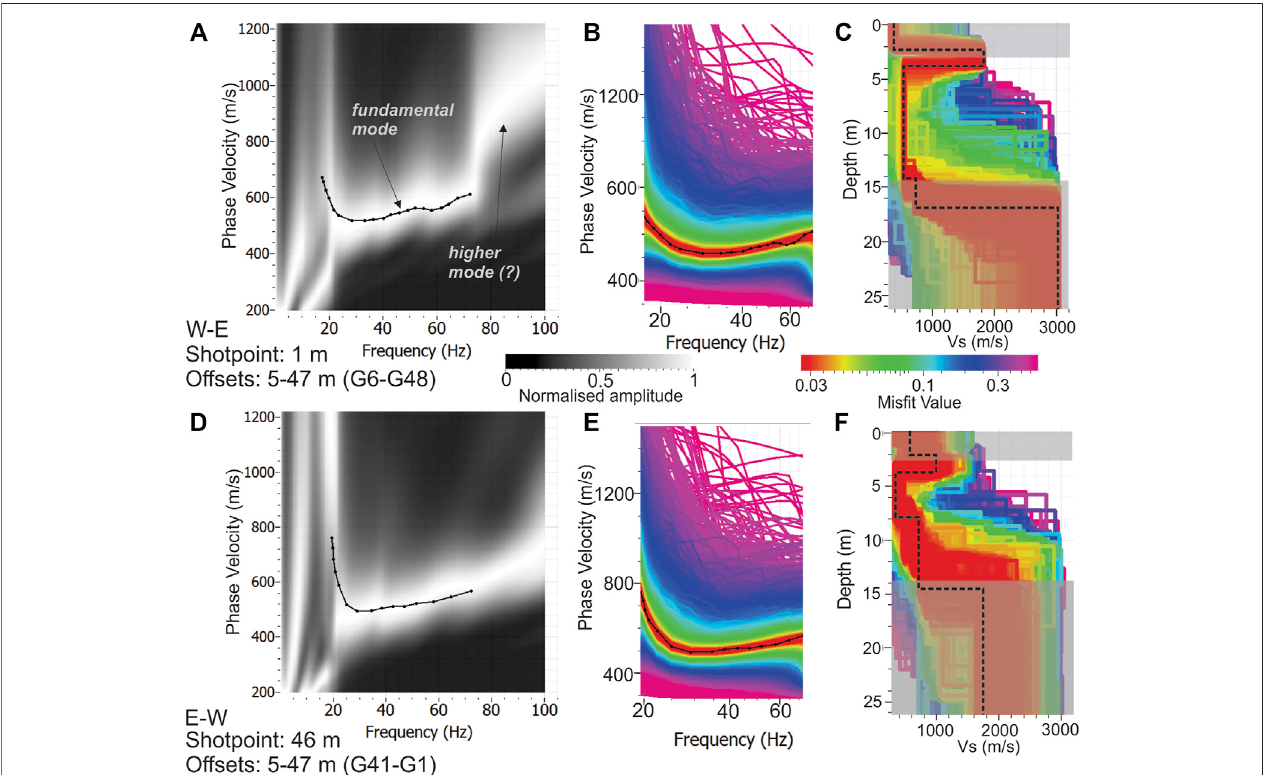
FIGURE 7 | MASW dispersion curves and inversion results from the Terminal Moraine Site: (A – C) use geophones G 6 to G 48 and shotpoint S 1 (shot direction: westtoeast;W − E)and (D – F) usegeophonesG41toG1andshotpointS46(shotdirection:easttowest;E − W).PickeddispersioncurvesforeachsiteareshowninA& D. All modelled dispersion curves tested in the inversion are shown in B & E, with corresponding mis fi ts plotted as the colour scale, high mis fi t models progressively overlain by lower mis fi t models, and picked values displayed in black. C & F show all v s pro fi les associated with the modelled dispersion curvesand corresponding mis fi ts, with minimum mis fi t v s pro fi le (black dashed line). The grey regions in C & F show approximate resolution limits de fi ned by Z min and Z max ( Table 1 ).